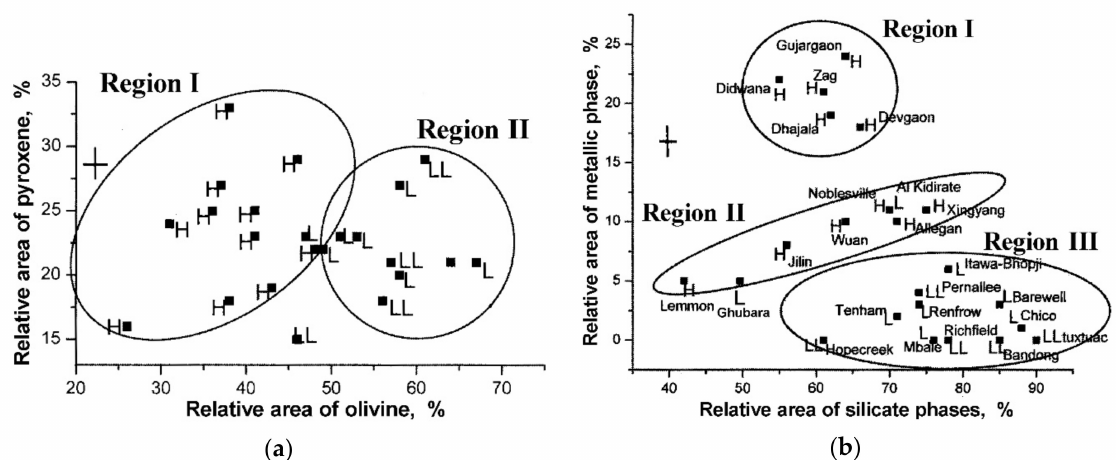
Figure 43. Classifications of H, L, and LL ordinary chondrites using the relative areas obtained from the Mössbauer spectra: the relative area of pyroxene vs. the relative area of olivine ( a ) and the relative area of metallic phase vs. the relative area of silicate phases ( b ). Adapted from References [56,117].